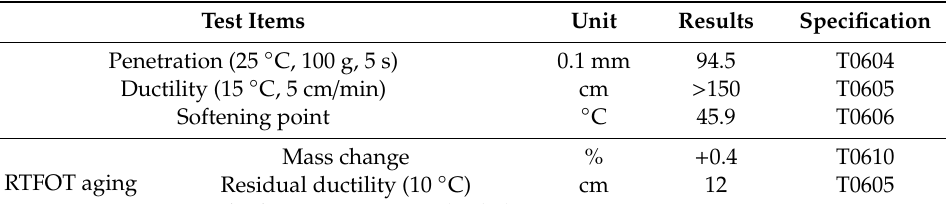
Table 1. Physical properties of SK-90# bitumen.